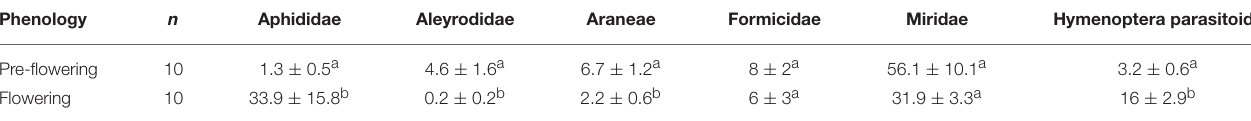
TABLE 4 | Average number (mean ± SE) of individuals of different taxonomic groups captured before and during the flowering period of D. viscosa located inside the olive groves. Phenology n